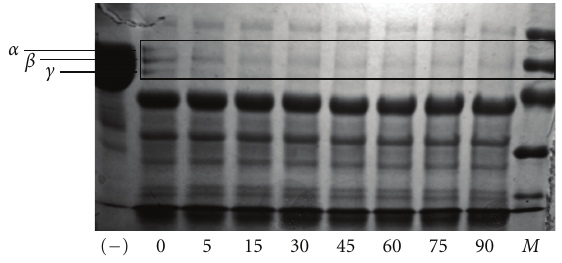
Figure 6: Fibrinogen degradation by DLBS1033. Lane 1: fibrino- gen. Lanes 2–8 representing mixtures aliquot were taken at 0, 5, 15, 30, 45, 60, and 90 min,